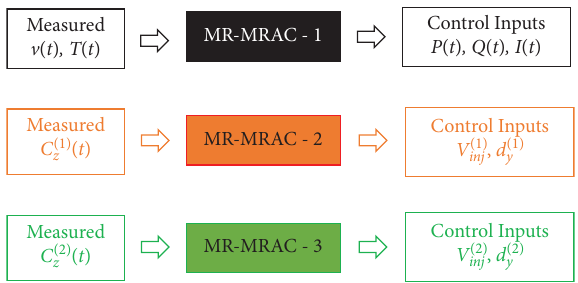
Figure 1: Schematics of a single torch-dual injector APSP for producing an FGC. Te plasma produced by the injection of Ar and H the torch exits from it at a very high temperature and speed. Powder particles injected into the plasma travel with it to the substrate and upon impact are deposited on it. Te y - and z -axes are, respectively, along and perpendicular to the plasma jet. Particles’ axial velocity and temperature are monitored in the 1 cm-wide observation window located near the substrate to be coated. Te particles shown are neither from experiments nor from